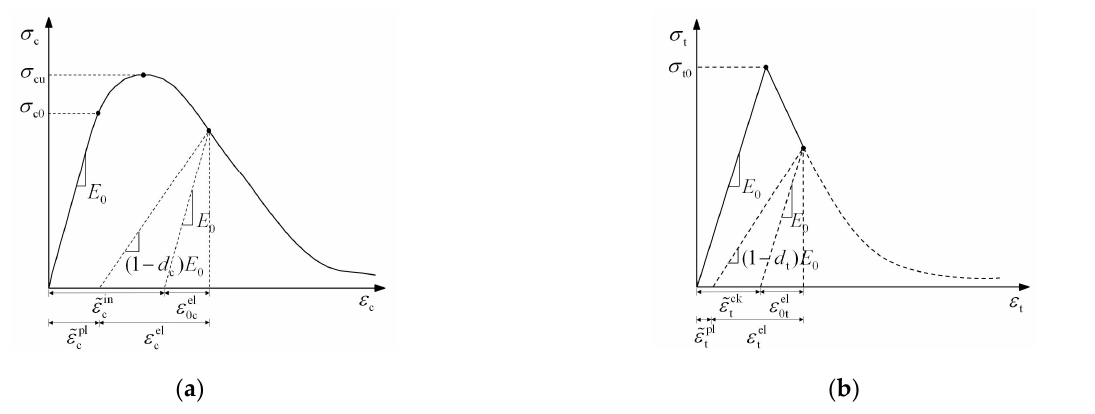
Figure 2. Stress–strain curve of CDP model: ( a ) Compressive; ( b ) Tensile. It is clear from Sidiroff energy equivalence principle [25] that the residual elastic energy resulting from a stress of a certain magnitude acting on a damaged material is formally the same as the residual elastic energy resulting from a stress acting on an undamaged material, so the stress or the modulus of elasticity can be changed to the effective stress or the equivalent modulus of elasticity at the time of damage when calculating the damage factor, using Equations (16) and (17). The results of damage factor calculations using the equivalent modulus of elasticity at effective stress or damage are the same. W e is 0 the residual elastic energy in the undamaged case, W e is the residual elastic energy in d the damaged case, and σ = ( 1 − d ) 2 σ is the effective stress considering damage. Using Equations (16) and (17) can lead to E d = E 0 ( 1 − d ) and Equations (18) and (19). The concrete uniaxial compression damage factor d c and the concrete uniaxial tension damage factor d t can be derived by coupling Equations (1) and (6) with Equation (19).